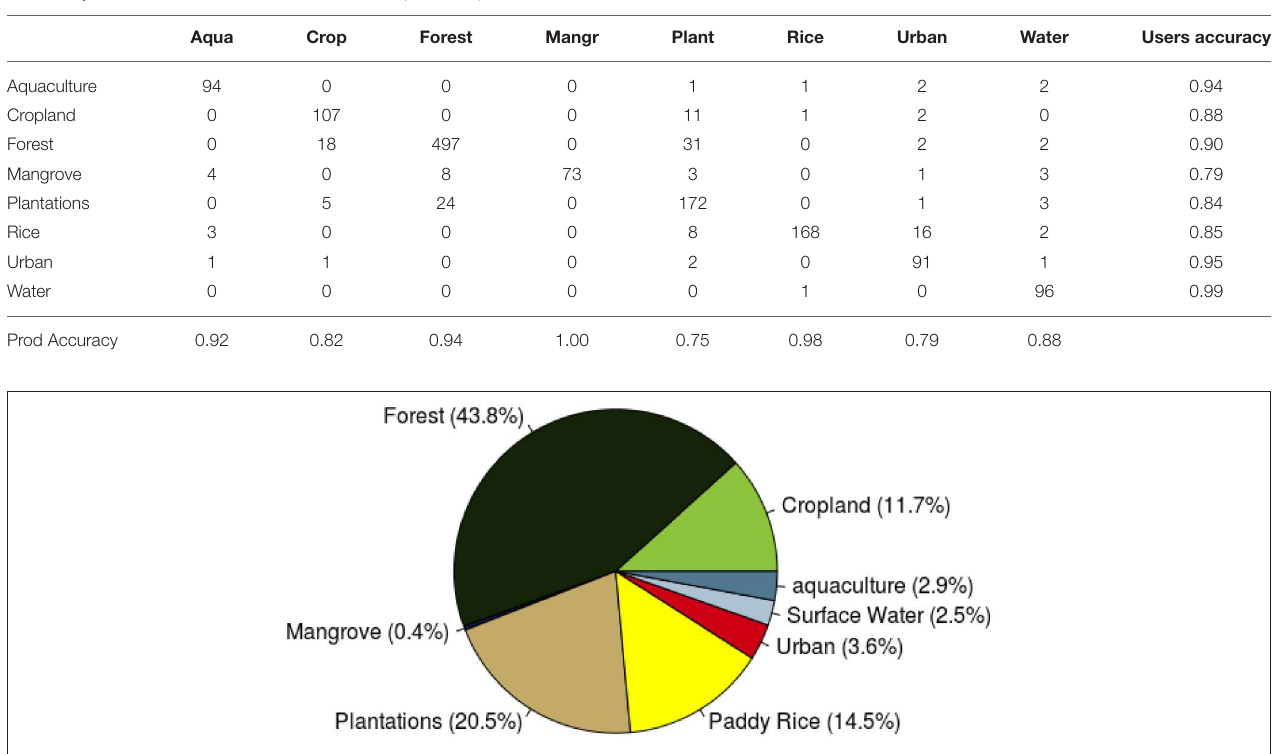
FIGURE 3 | Land cover area distribution of Vietnam in 2017.